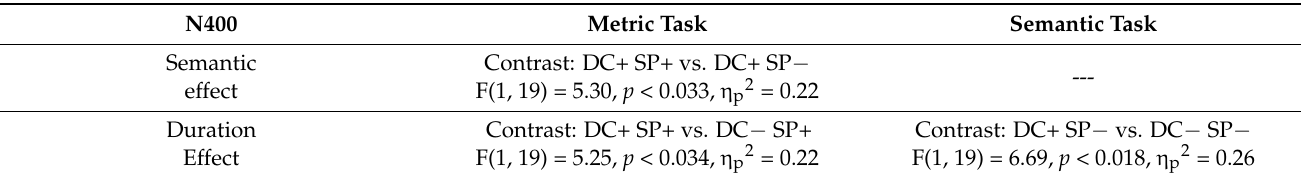
Figure 5. Grand average waveforms of LPC component for DC+ SP+ and DC − SP+ contrast con- ditions as a function of metric task (see Figure 3A for the four experimental conditions). The time windows with a contrast are indicated in gray. The dotted lines indicate the standard deviations. Left : spatial distributions resulting from the comparison between the conditions. The asterisks at the topographical maps show the used electrodes. Right : current density values for the contrast and their brain spatial localization for the duration contrast (LPCC). Table 3. F and significant p values from Task, Duration and Semantic interaction for the early window.